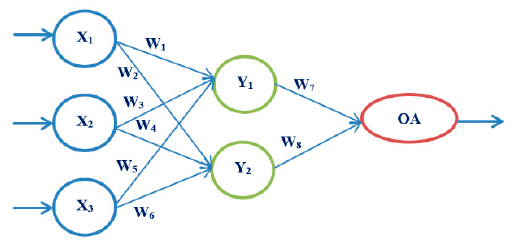
Figure 1. ANN architecture with one hidden layer based on OA18 (ANN-OA18).